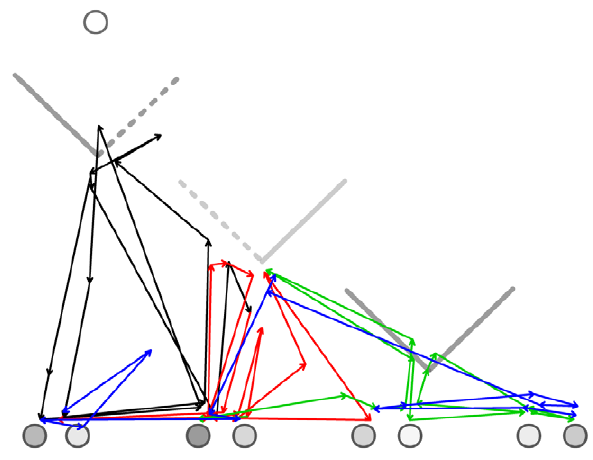
Figure 3. Example of a participant’s fixations in a particular game. The succession of fixations is indicated by arrows, which are superimposed on the payoffs and trapdoors (i.e., decision points). The first 15 fixations are depicted in black, fixations 16–30 in red, fixations 31–45 in green, and fixations 46–61 are depicted in blue. The succession of fixations on payoffs and trapdoors seems to indicate forward reasoning, followed by backtracking, which is indicated by the blue arrows that eventually go back to the first payoff